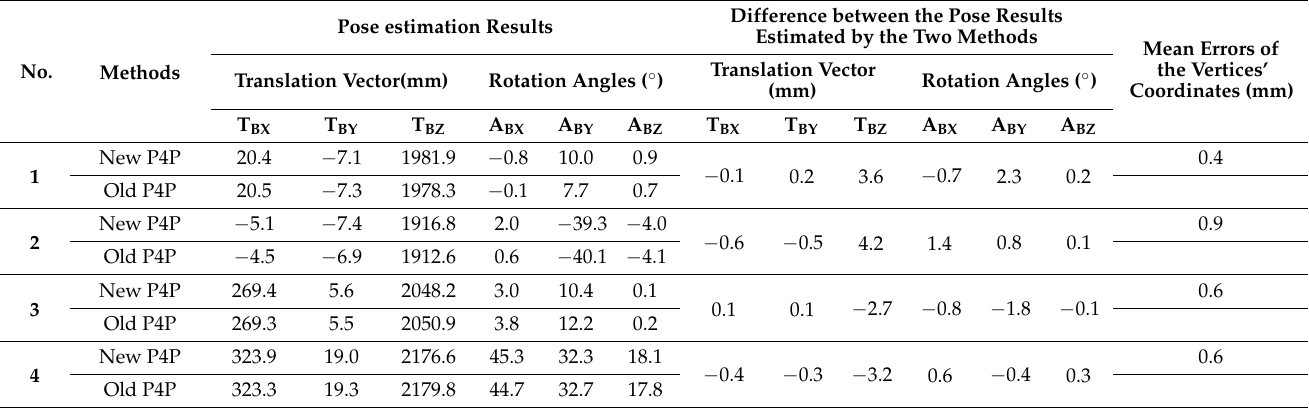
Table 1. Shape and pose estimation results of a parallelogram object in